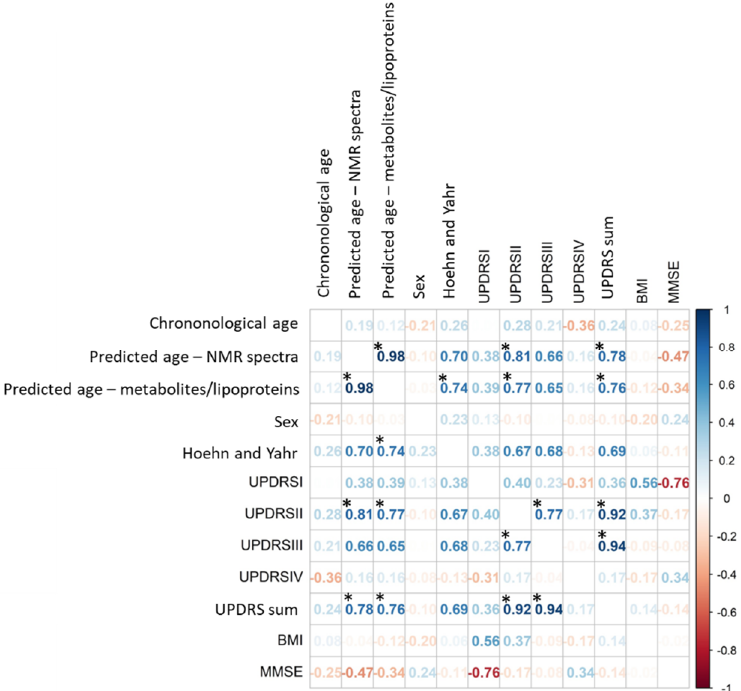
Figure 2. Pearson’s correlation coefficients among predicted age (estimated using PLS), severity scores, and other demographic and physiological variables. Data are obtained using the advPD cohort. Asterisks represent p -values <